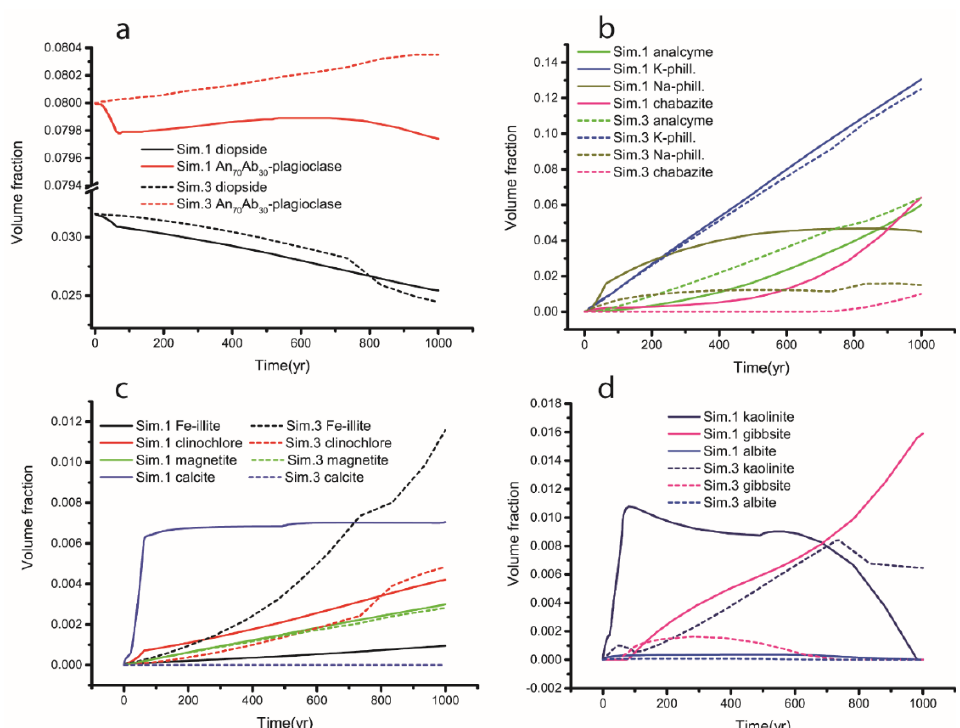
Figure 8. Simulations 1 and 3: mineral evolution (fraction volume) over time at 165 °C and PCO 2 = 1.2 bar (Sim. 1, solid lines) and PCO 2 = 0.012 bar (Sim. 3, dash lines). Initial volume fraction as reported in Table 7. ( a ) Primary diopside and An 70 Ab 30 -plagioclase; ( b ) secondary zeolites; ( c ) secondary Fe-illite, clinochlore, magnetite and calcite; ( d ) secondary kaolinite, gibbsite and albite.